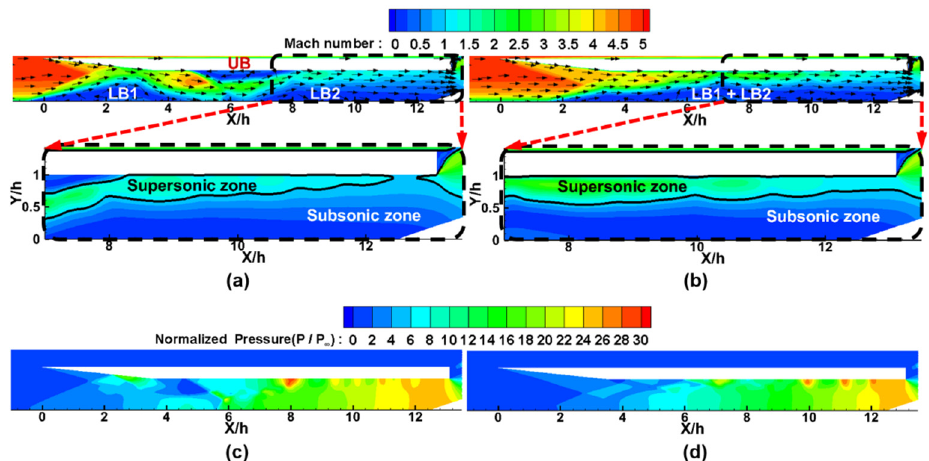
Figure 9. Comparison of the flow configurations of Patterns 1 and 2: ( a ) Mach number, velocity vectors at point [c’] (Pattern 1); ( b ) Mach number, velocity vectors at point [c 2 ] (Pattern 2); ( c ) normalized pressure at point [c’] (Pattern 1); ( d ) normalized pressure at point [c 2 ] (Pattern 2).